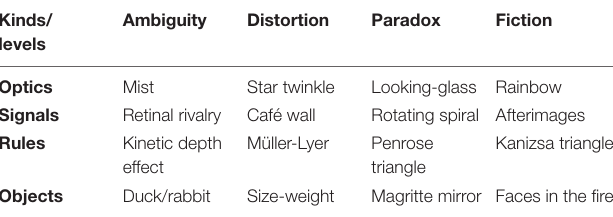
TABLE 1 | Gregorian categories of